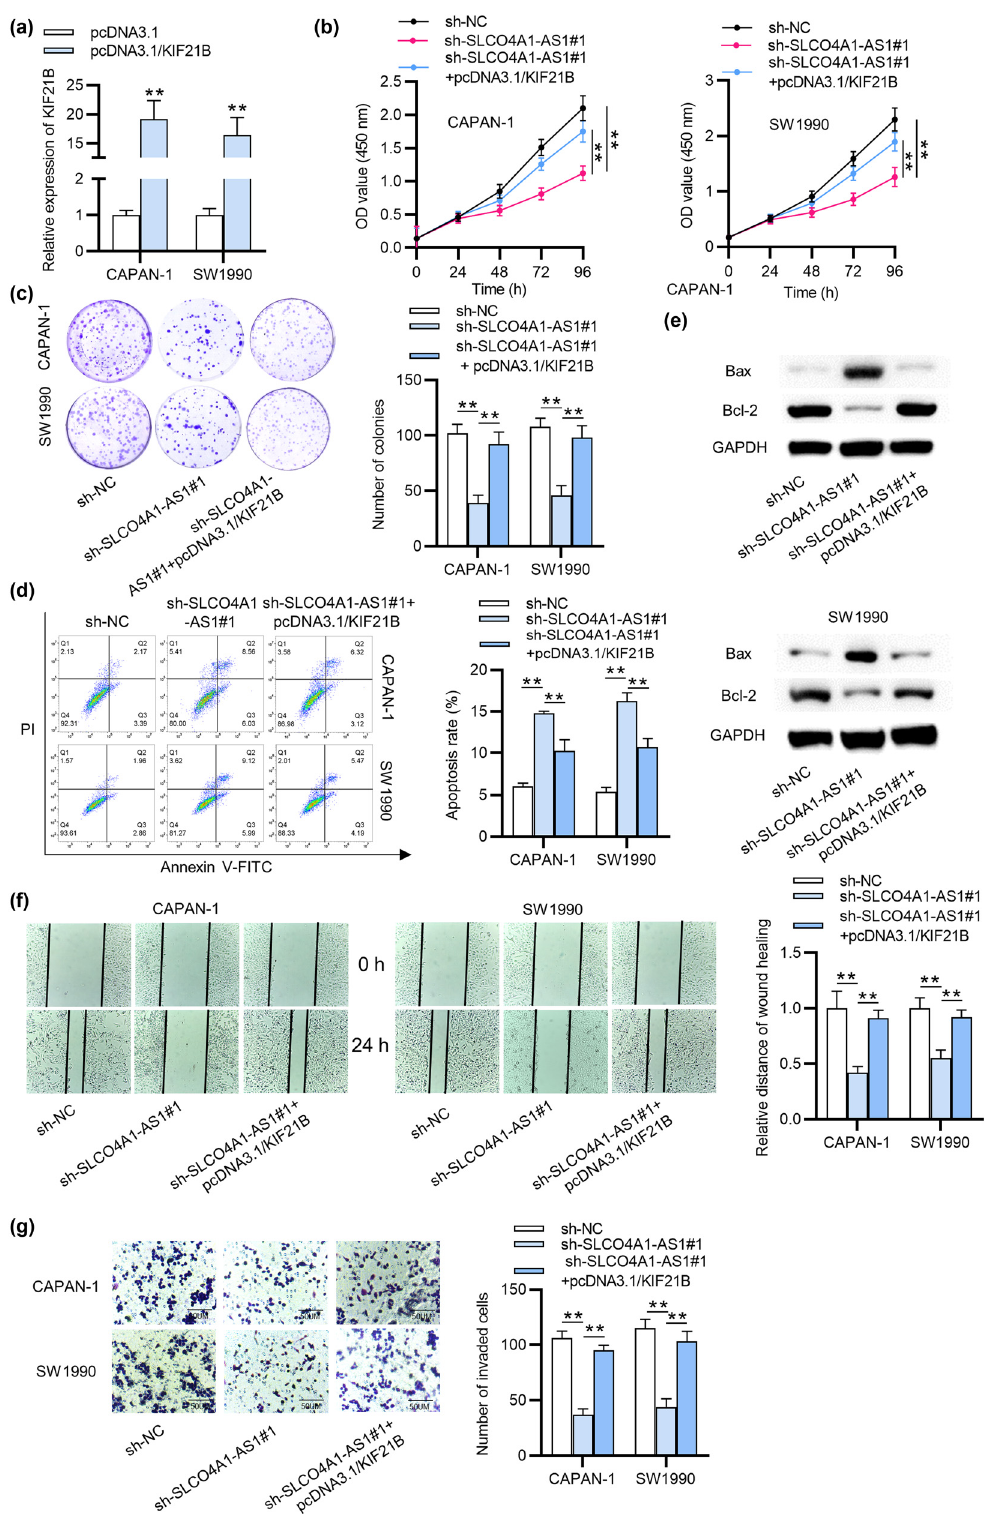
Figure 5: SLCO4A1 - AS1 accelerates the cellular process of PC through regulating KIF21B. ( a ) qRT - PCR detected the overexpression e ffi ciency of KIF21B in PC cells. ( b ) CCK - 8 assay was carried out to investigate the impact of upregulated KIF21B on suppressed cell viability caused by depleting SLCO4A1 - AS1. ( c ) The SLCO4A1 - AS1 silence - reduced proliferation capacity of PC cells was a ff ected by KIF21B overexpression, as indicated by colony formation assay. ( d and e ) The apoptosis of PC cells transfected with appointed plasmids was analyzed by fl ow cytometry and western blot analysis. ( f ) The in fl uence of SLCO4A1 - AS1 knockdown on KIF21B overexpression - enhanced migrated capability of PC cells was determined by wound healing assay. ( g ) The change in invasive capability of PC cells with designated transfections was investigated by Transwell assay. All experiments were performed in triplicate. More images for replicates are provided in a supplementary fi le named Replicate images. ** p <